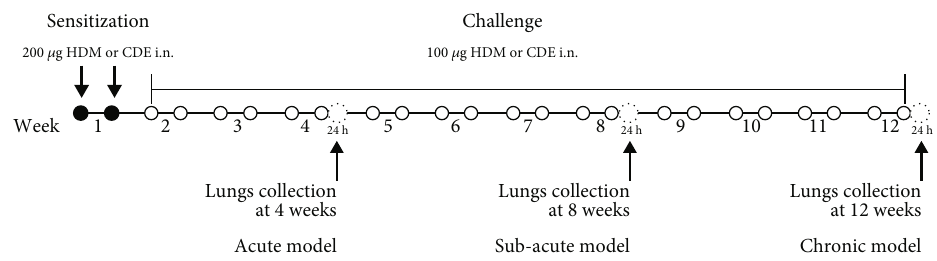
Figure 1: Sensitization and challenge protocols. Experimental models of acute (4 weeks), subacute (8 weeks), and chronic (12 weeks) HDM- or CDE-induced allergic airway in fl ammation in guinea pigs. The protocol for allergen exposure involved a sensitization phase (black dots) followed by a challenge phase (open